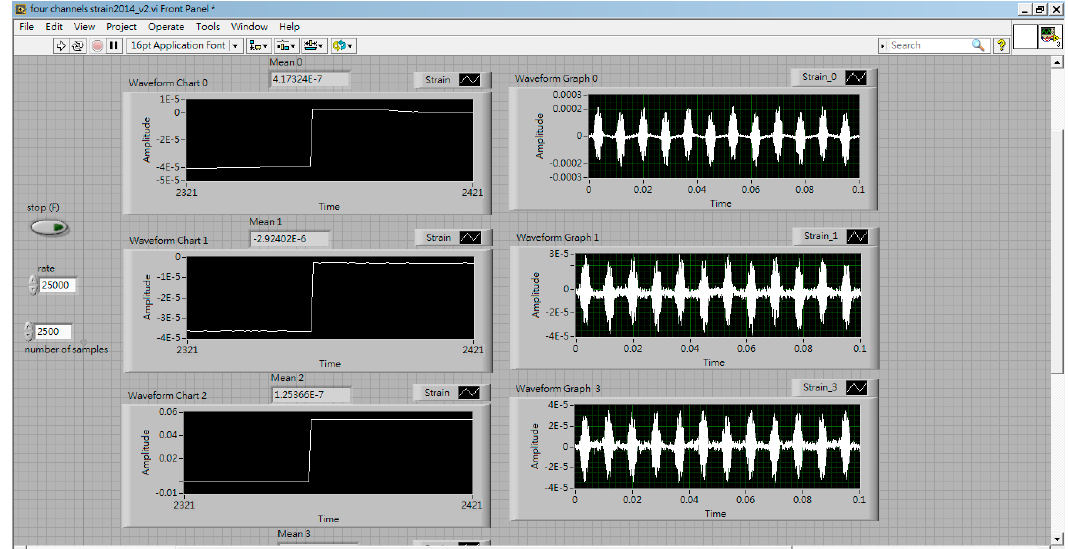
Figure 7. The relationship of loading and time in MTS.